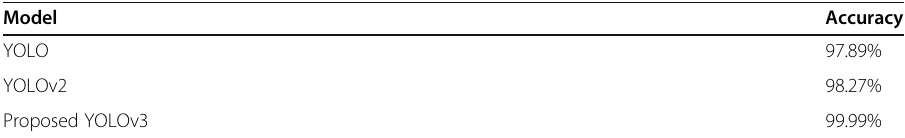
Table 1 Comparison of three YOLO models